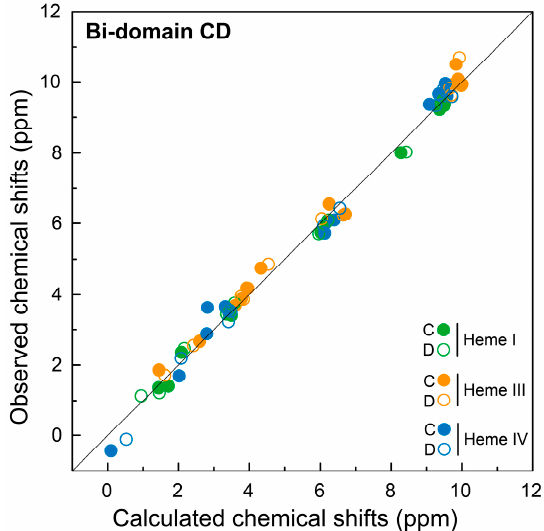
Figure 7. Comparison of the observed and calculated chemical shifts of the heme protons from hexaheme bi-domain CD. The calculated values were obtained from the crystal structure of the bi-domain CD (PDB code 3OUE [15]). The heme signals corresponding to domains C and D in the bi-domain CD are represented by filled and open circles, respectively. The solid line has a unit slope. The RMSD values of the hemes I, III and IV are, respectively, 0.02, 0.05 and 0.07 for domain C and 0.02, 0.04 and 0.03 for domain D.